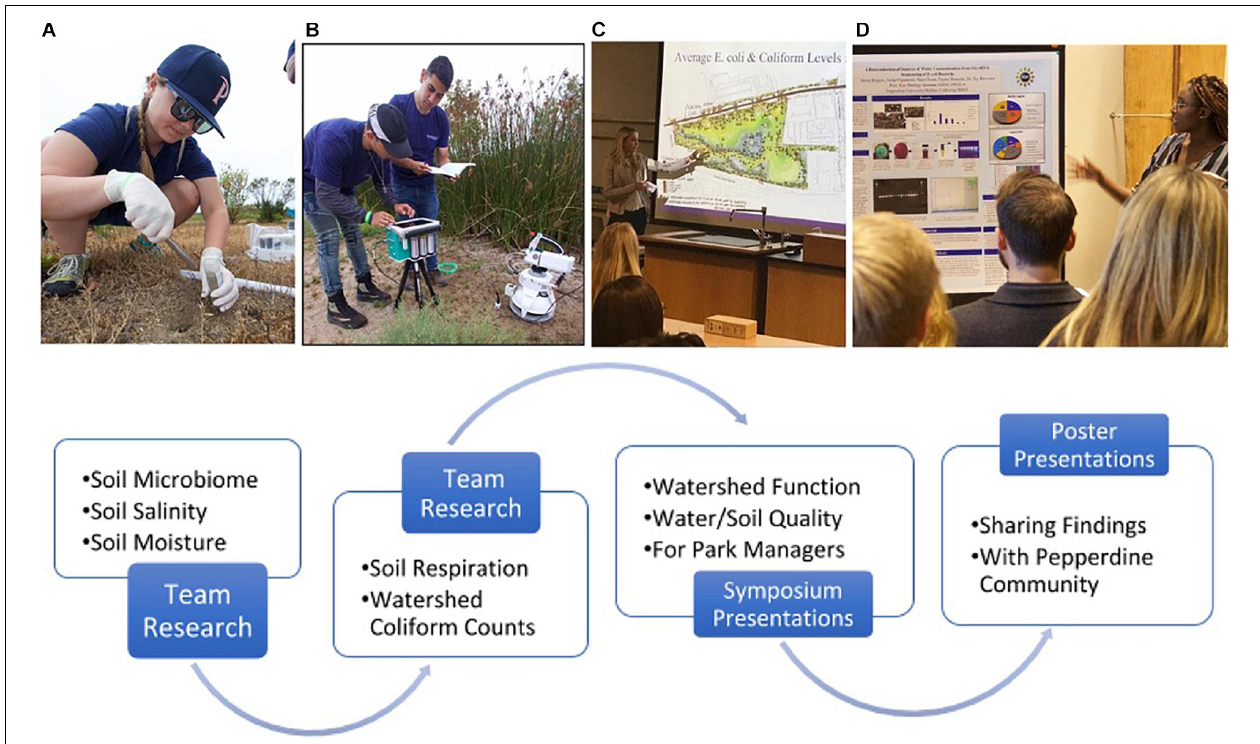
FIGURE 1 | SAS-Program Activities: Pepperdine students (A) collecting soil samples for microbiome, salinity, and moisture analyses; (B) measuring soil respiration with a field-portable CO 2 flux chamber and gas-exchange system; (C) giving symposium presentations on water and soil quality for environmental managers of coastal wetlands; and (D) sharing research findings in a final poster session for Pepperdine University’s community of learners, attracting over 120 participants. Photos by SD Davis.